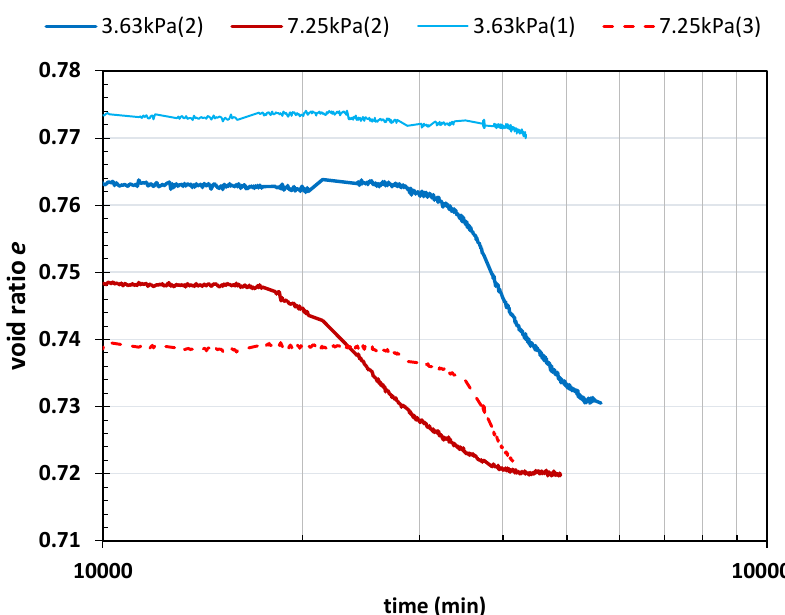
Figure 15. Volumetric shrinkage observed over time on a selected group of samples among those subjected to imbibition tests.